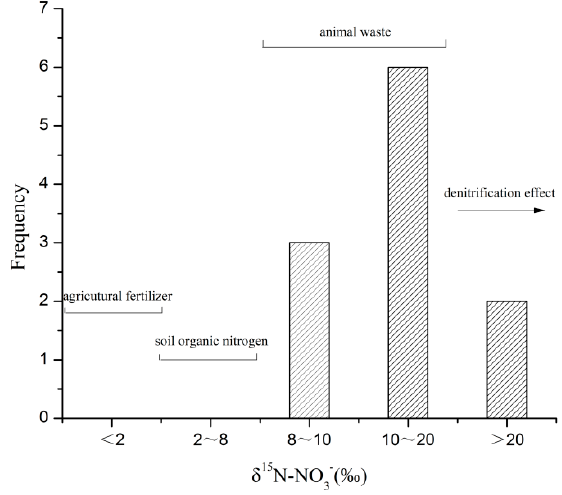
´ in surface waters of the Weihe River 3